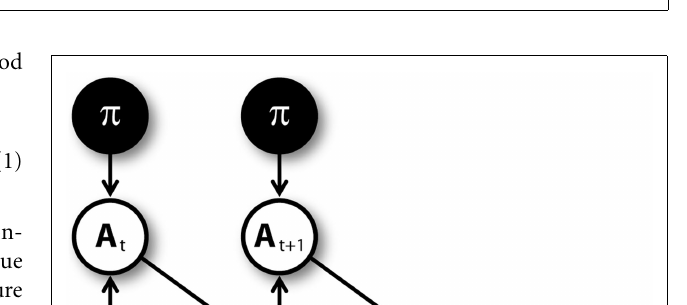
FIGURE 2 | Overview of the mixed instrumental controller (MIC).